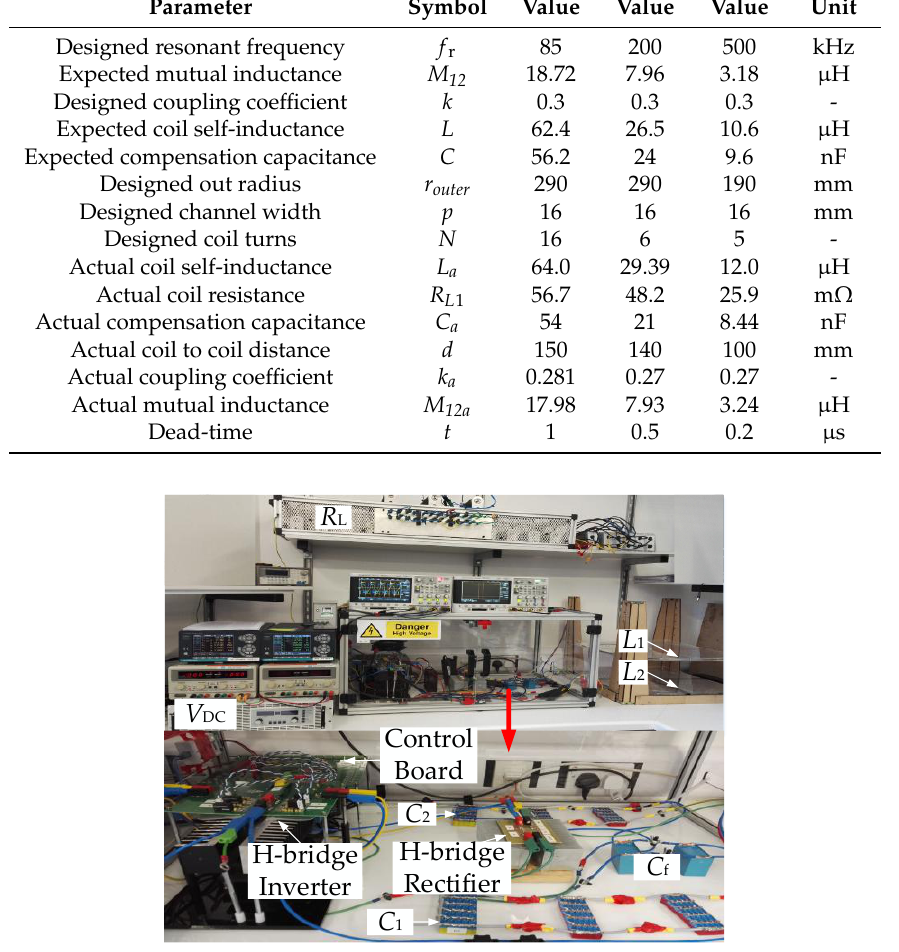
Table 1. Design parameters for coil systems with three different resonant frequencies.